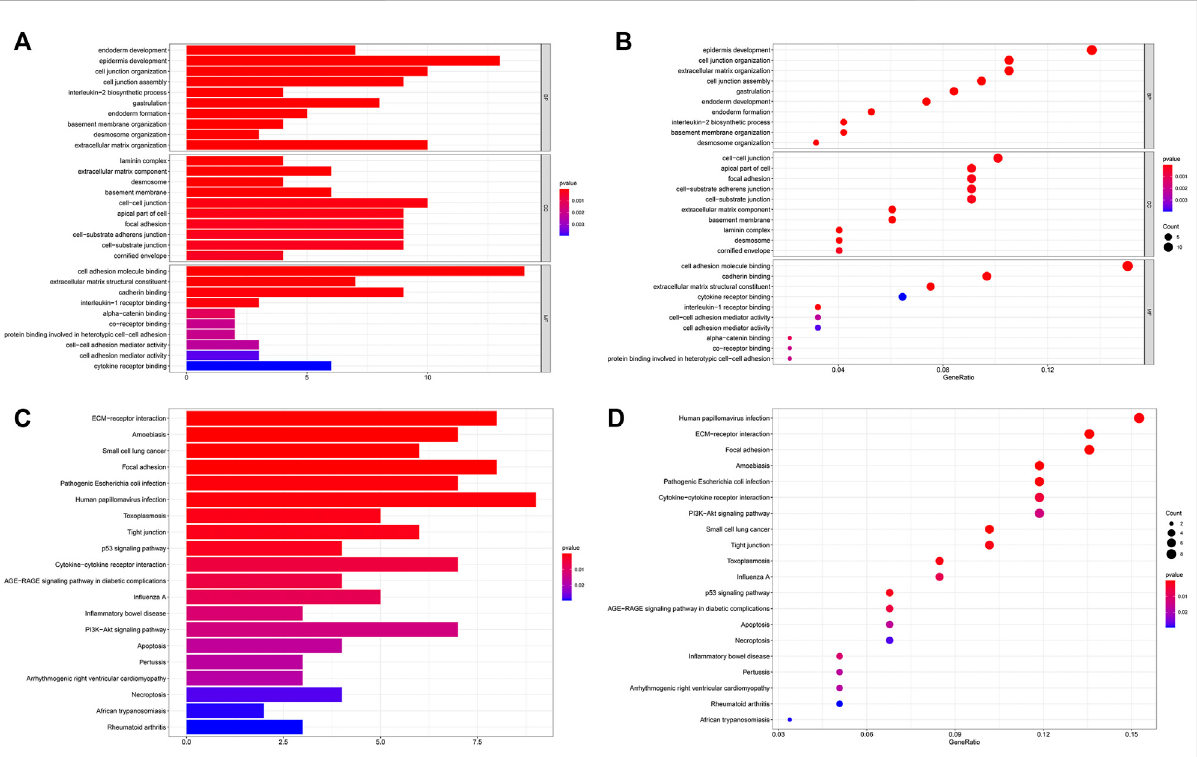
FIGURE 10 GOtermsandtheKEGGpathway. (A) Histogrampresentationofthetop10positionsofGOintermsoftargetgenesinbiologicalprocesses(BP), cellular components (CC) and molecular functions (MF) of biology; (B) Bubble chart of the top 10 positions of GO in terms of target genes in BP, CC, MF; (C) Histogram presentation of pathways related to the differentially expressed genes by the KEGG analysis; (D) Bubble chart of pathways related to the differentially expressed genes by the KEGG analysis.